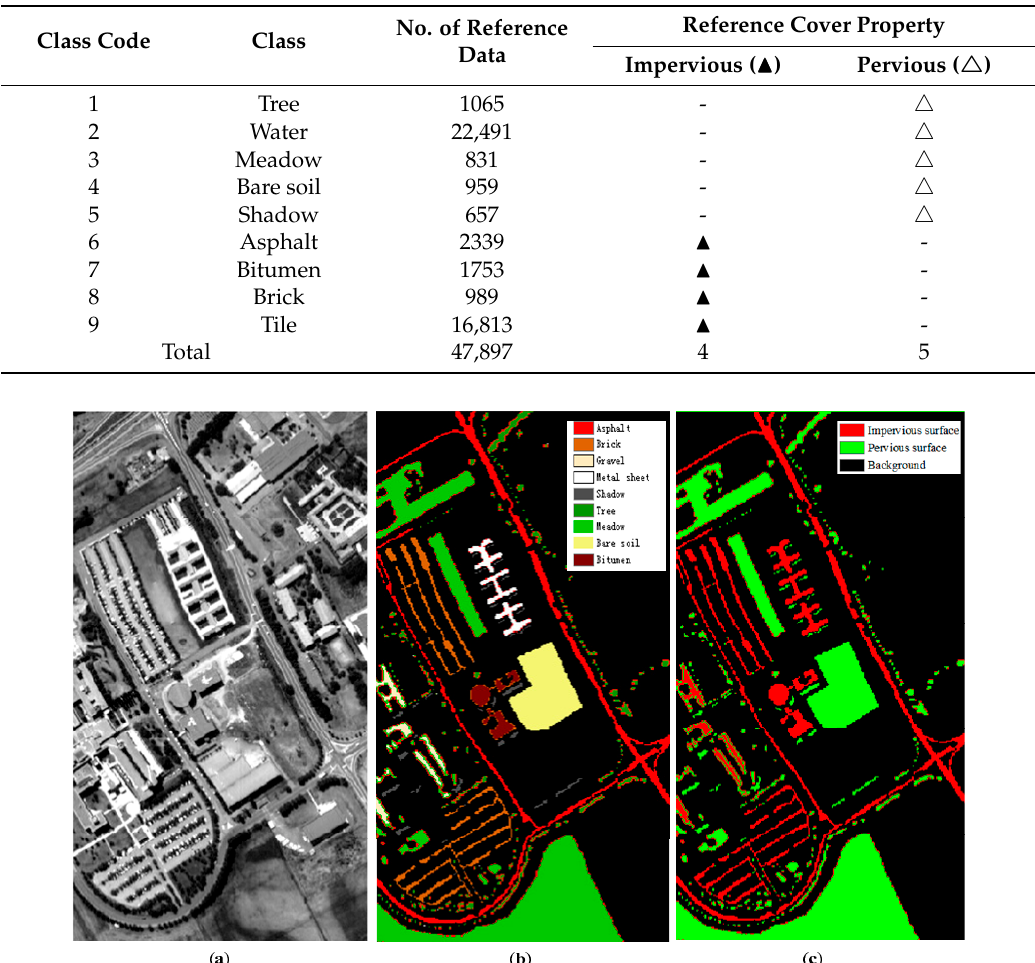
Figure 1. The university scene of the Pavia: ( a ) single band image; ( b ) reference of ground-truth image; and ( c ) reference of impervious surface image.